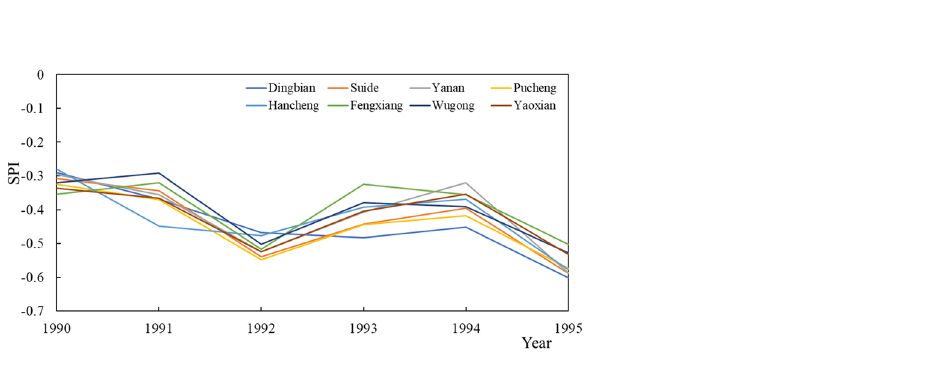
Figure 4. SPI changes at each site from 1990 to